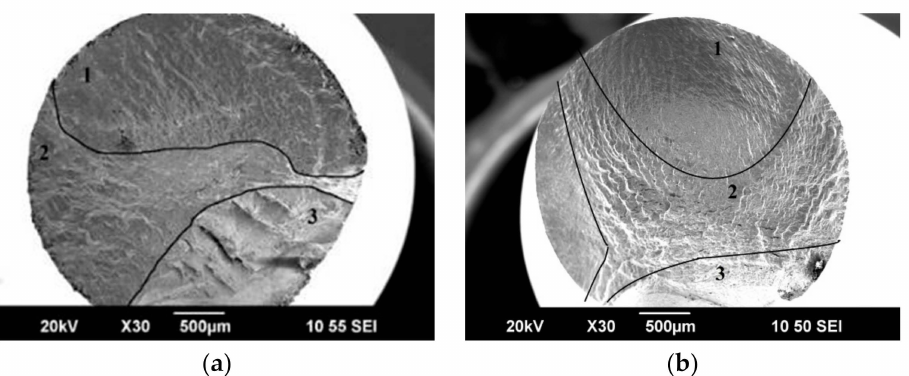
Figure 6. The fracture surface: ( a ) after CR 50% and ( b ) after CR + requenching. The surface of higher magnification is shown in Figures 6 and 7. 1—crack initiation zone, 2—zone of the crack propagation, 3—rupture zone. SEM